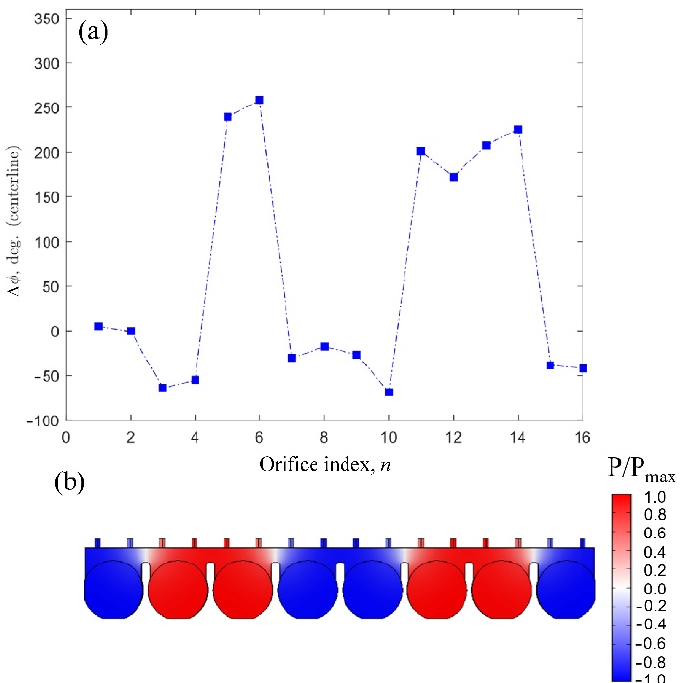
Figure 10. ( a ) Variation of the phase-angle difference between the phase-averaged peak jet velocity at the orifice centre and the peak input excitation along all 16 orifices for the excitation of the unified cavity at the frequency of f e = 1200 Hz, which is an on-resonance peak, and ( b ) the variation of the instantaneous acoustic pressure within the unified-cavity volume for the corresponding acoustic mode at the natural frequency of f s = 1252 Hz.